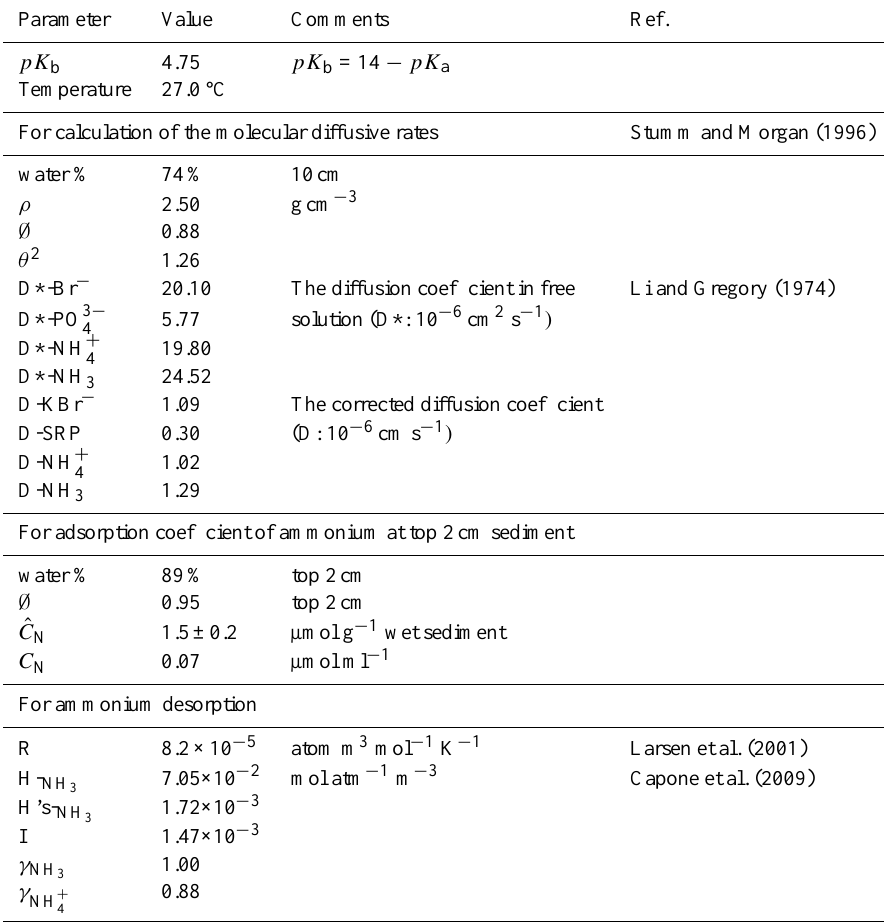
Table 3. The kinetic parameters used in calculation of diffusion rates and in calculation of ammonium adsorption-desorption in sediments. Parameter Value Comments Ref. pK b 4.75 pK b = 14 − pK a Temperature 27.0°C For calculation of the molecular diffusive rates Stumm and Morgan (1996) water % 74%